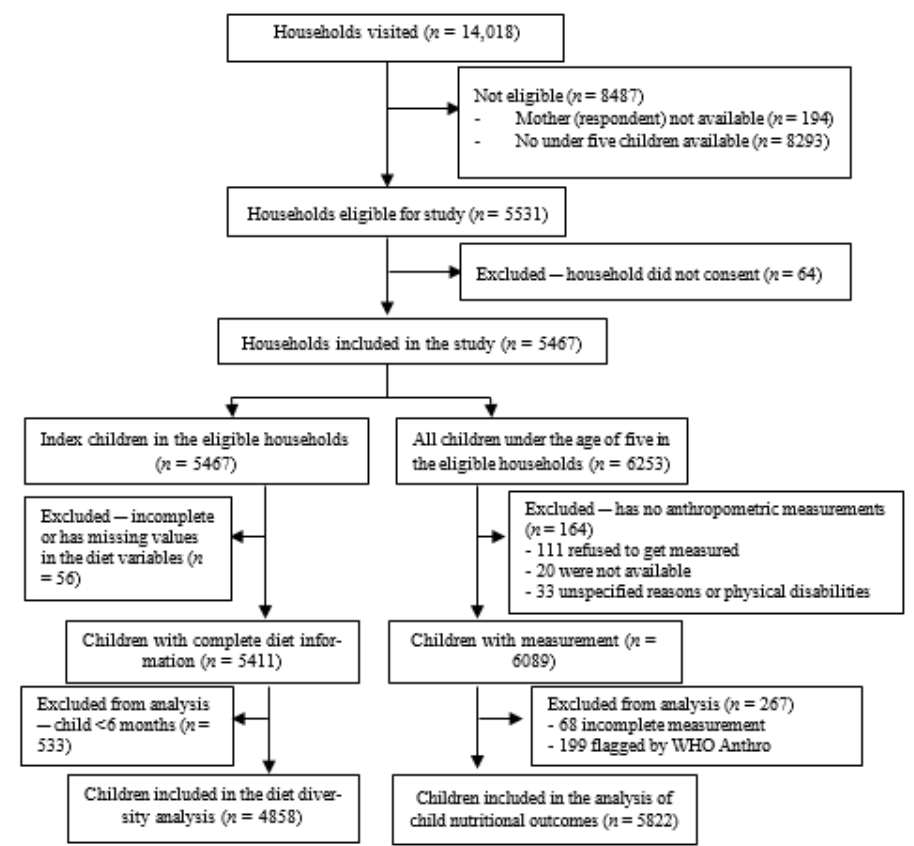
Figure 1. Flowchart of households and children included in the diet and child nutrition study in Addis Ababa, Ethiopia.